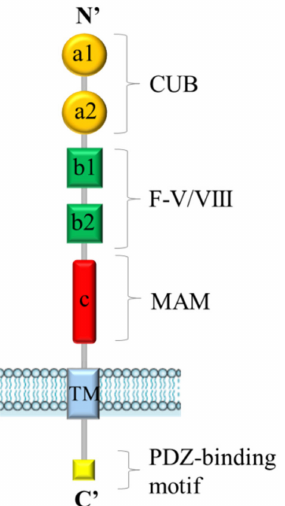
Figure 1. General structure of Neuropilins. Both Neuropilin-1 (NRP1) and Neuropilin-2 (NRP2) contain five extracellular domains (a1 / a2, b1 / b2 and c domains), a single transmembrane (TM) stretch, and an intracellular PDZ domain-binding motif at